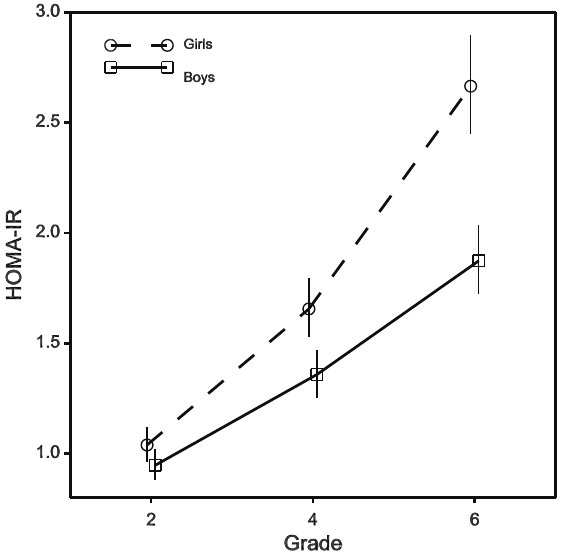
Figure 1. Mean values and 95% confidence intervals of HOMA- IR classified by sex and elementary school grades 2, 4, 6, where average age was 8, 10, and 12 years respectively. Table 1. Unadjusted median values, with 5 th and 95 th percentiles, with numbers of observations of anthropometry, physical activity, fitness, percent body fat and pubertal maturation stage classified by elementary school grade, gender and expressed as medians and percentiles.